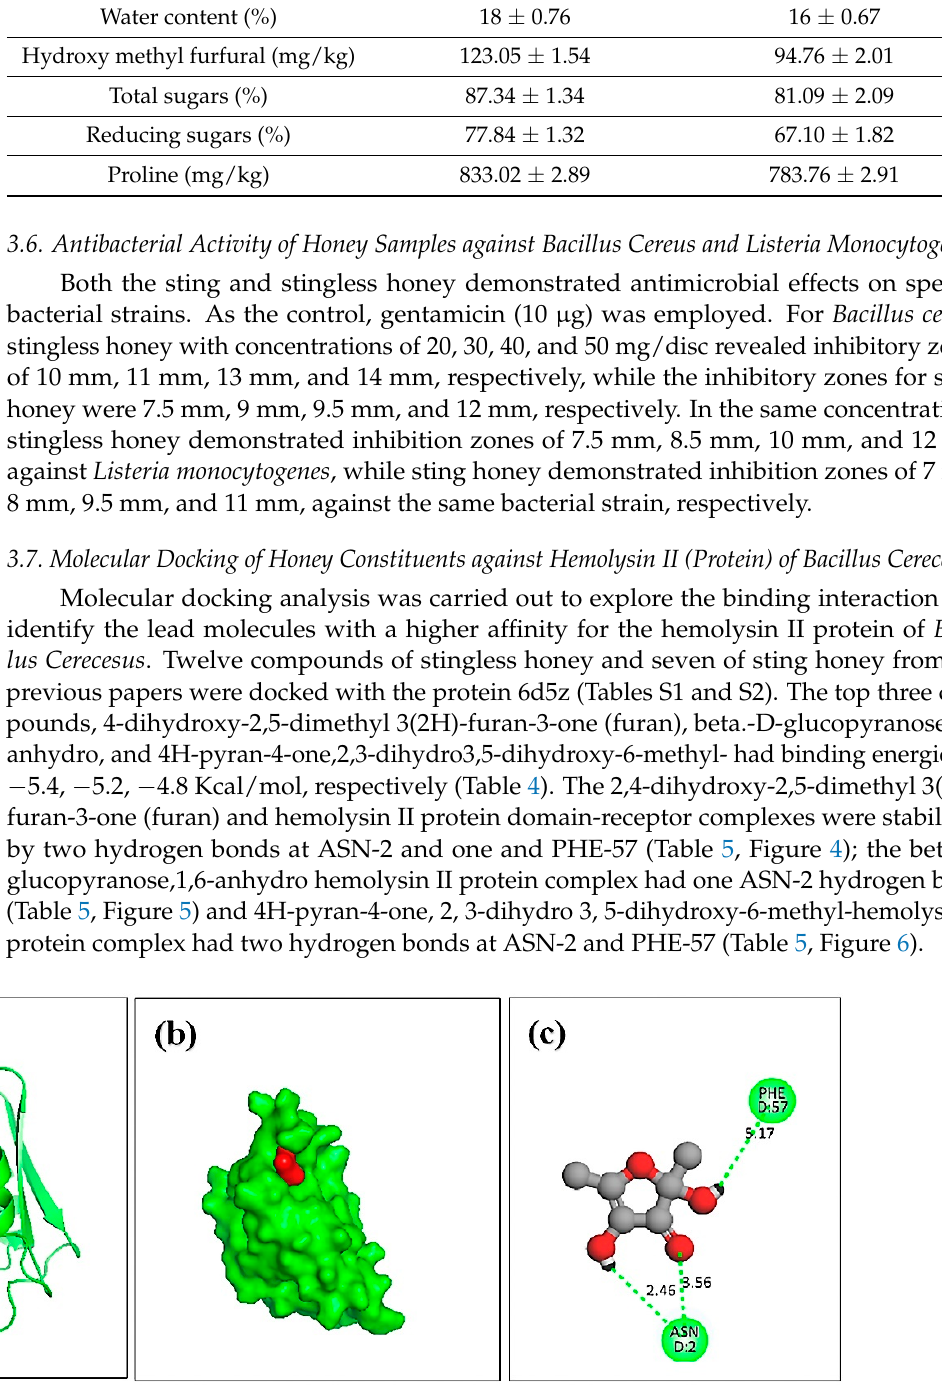
Figure 4. Docking simulation between the spike receptor-binding domain of hemolysin II (pro- tein) and 2,4-dihydroxy-2,5-dimethyl 3(2H)-furan-3-one (furan), where ( a ) shows the cartoon view, ( b ) surface view, and ( c ) 2D